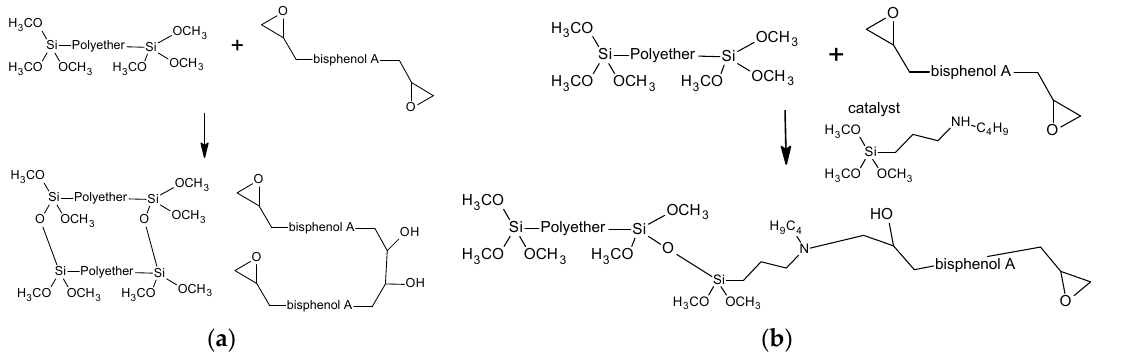
Figure 2. Reaction scheme of two ‐ component SIL/EP system (( a ) without compatibilizer, ( b ) with compatibilizer).